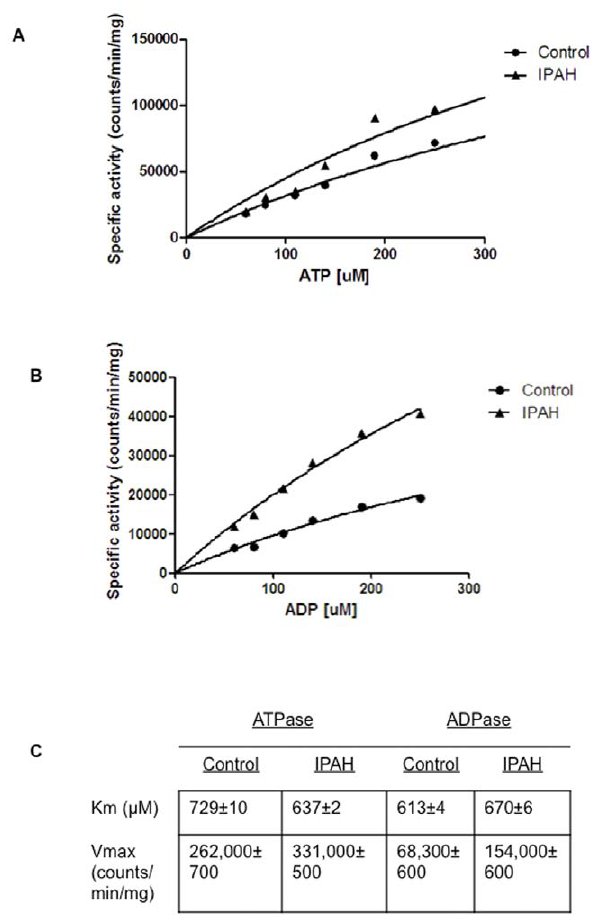
Figure 6. A comparison of ATPase (A) and ADPase (B) activities of microparticles from healthy controls and IPAH patients. Km and Vmax values are shown ( C ). Non-linear regression was used to fit experimental data to the curves using the Mihaelis-Menten equation. Data are means 6 SEM from triplicate experiments using microparticles isolated from three healthy controls and three IPAH patients.